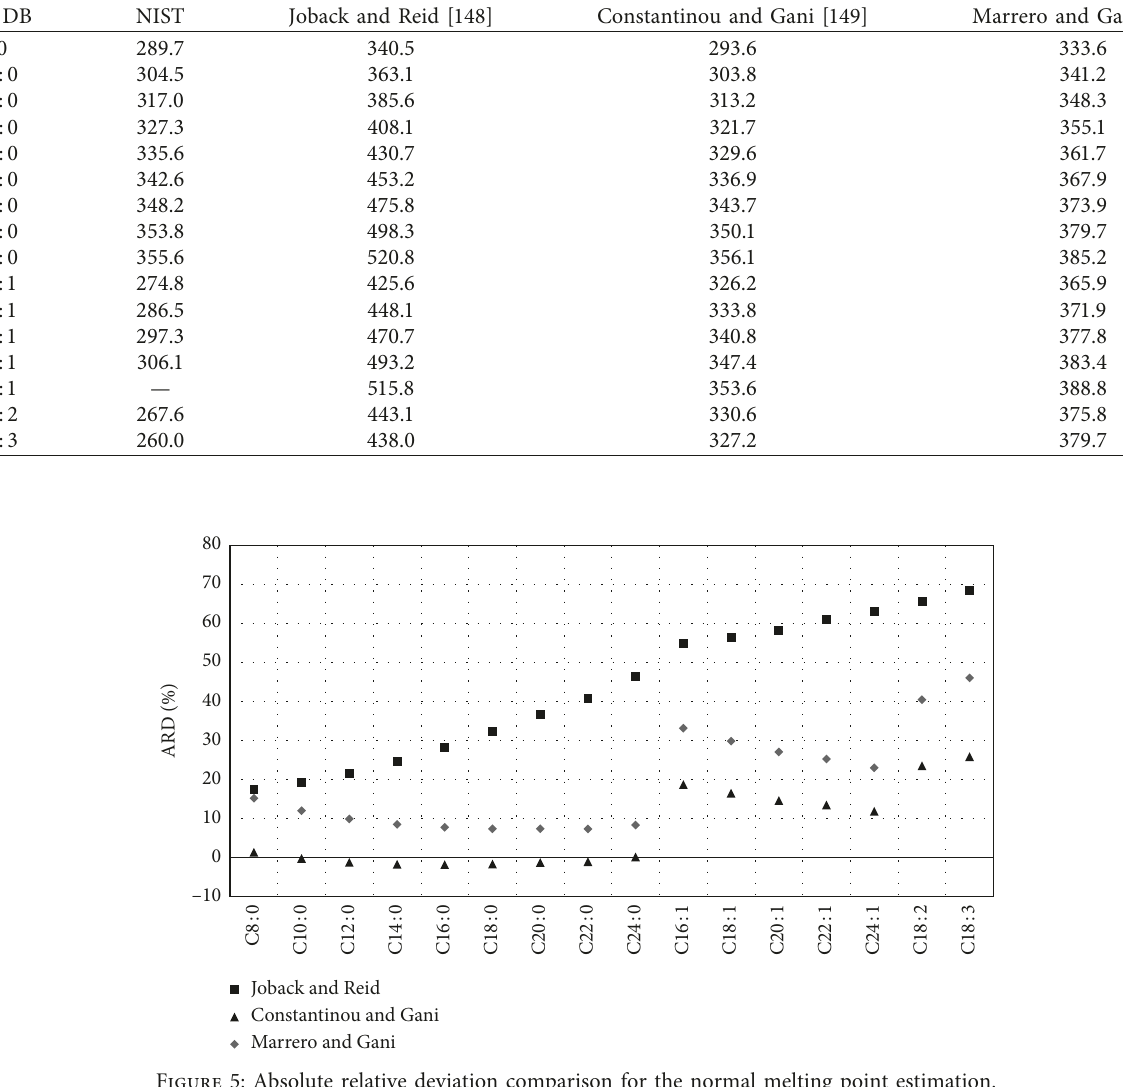
Table 8: Comparison of experimental and estimated normal melting point (K).